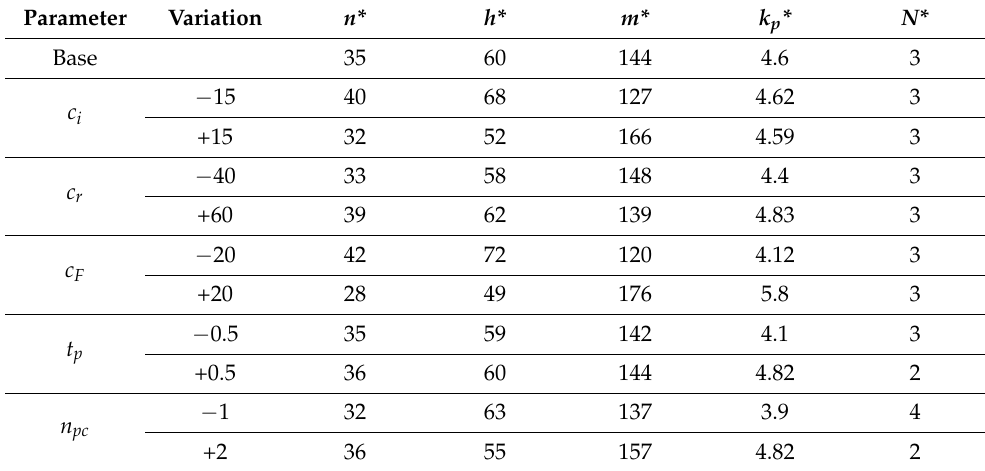
Table 18. Sensitivity analysis of different parameters. (* denotes the optimal